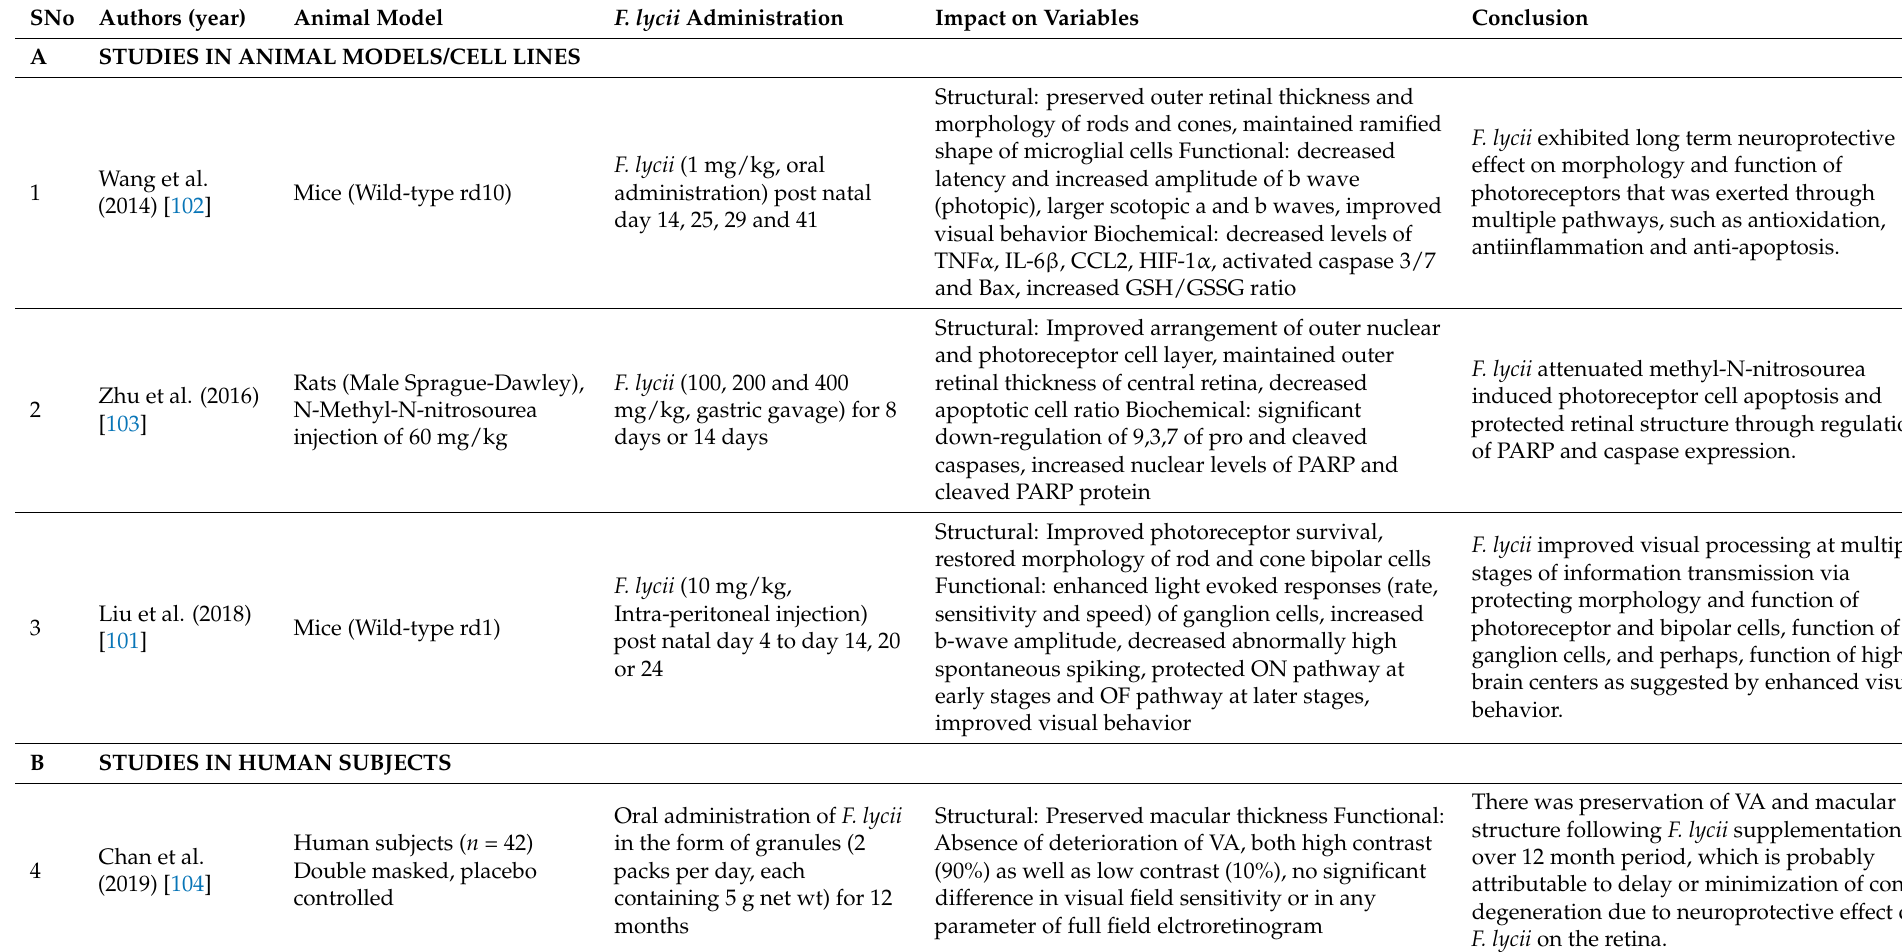
Table 4. List of studies that have evaluated F. lycii and retintis